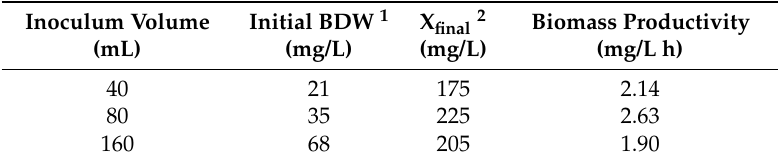
Figure 6. ( A ) D10, D50, and D90 value of particle size distribution of pre ‐ culture and fermentations at different initial inoculum concentration at 72 h (volumetric power input: 1.7 W/m 3 , temperature: 24 °C, the points at 0 W/m 3 volumetric power inputs indicates the pre ‐ culture); ( B ) oxygen profile during the fermentation at the initial inoculum concentration of 21, 35, and 68 mg/L. Table 2. Kinetic parameters of L. edodes fermentation at different initial inoculum concentrations in a 1 L stirred tank bioreactor. Data were part of a DoE with four repetitions of the center point experiment. The corresponding experimental standard deviation was below 14%.